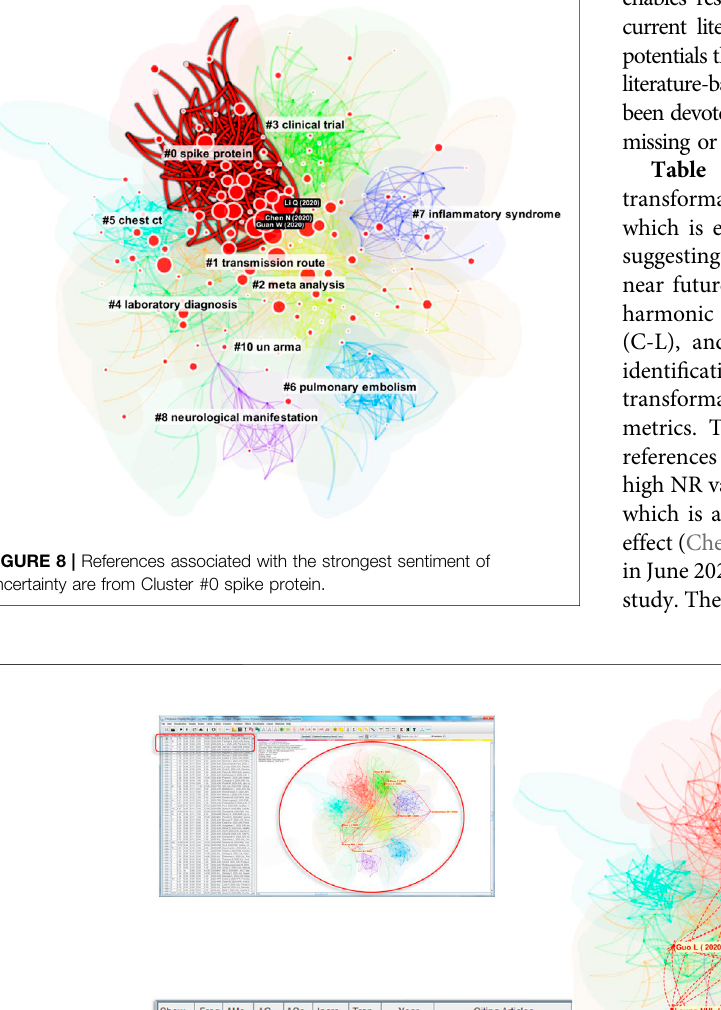
Frontiers in Research Metrics and Analytics |